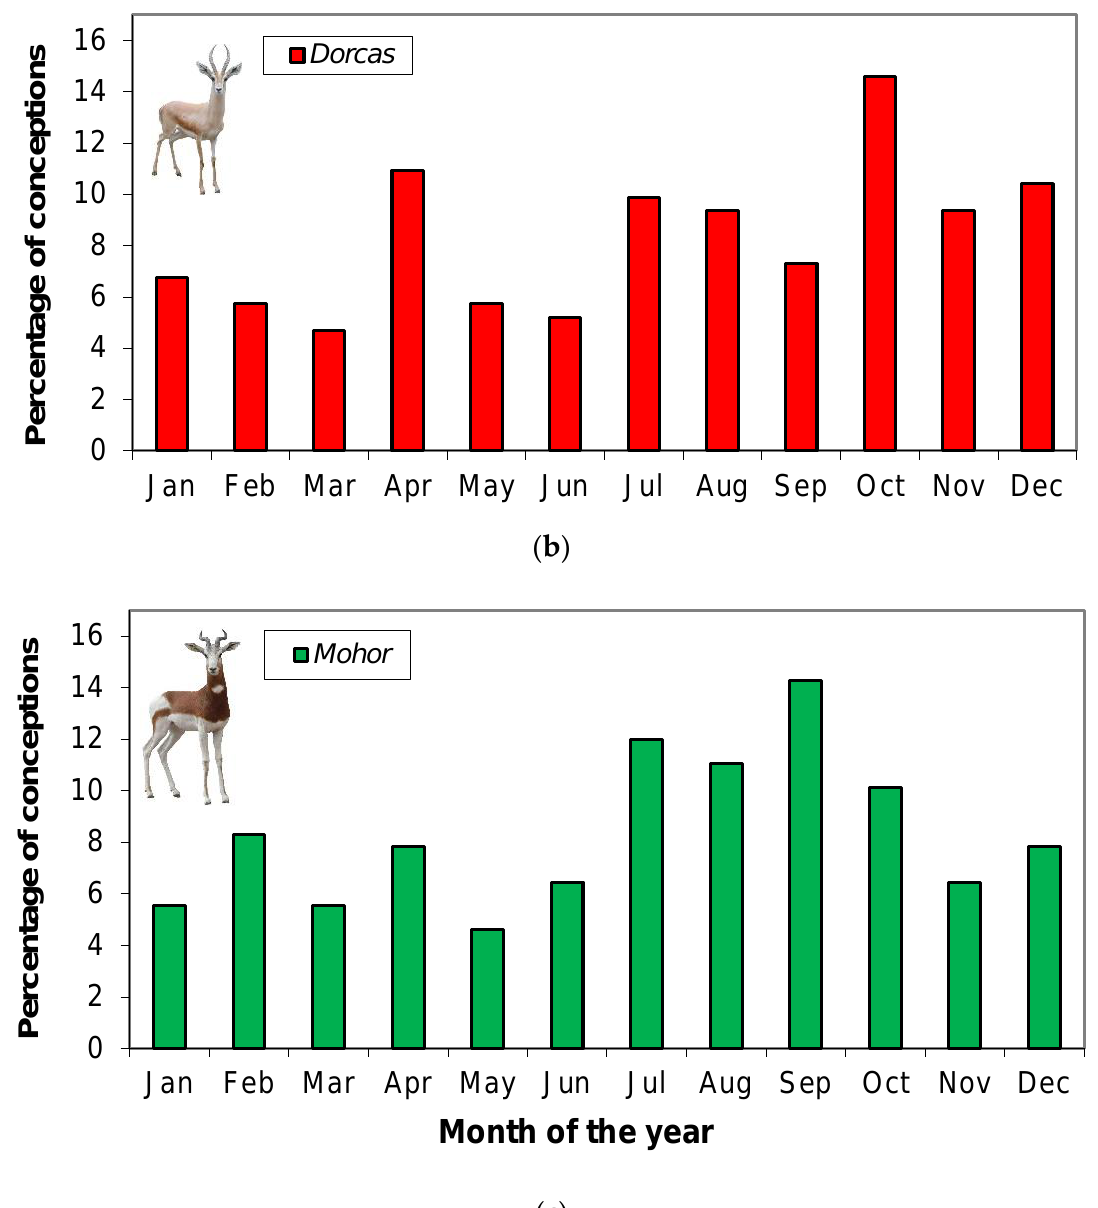
Figure 2. Distribution of conception dates for ( a ) Cuvier’s gazelle, ( b ) dorcas gazelle and ( c ) Mohor gazelle, data of dates of birth at Estación Experimental de Zonas Á ridas from January 1995 to December 2005 were taken from studbooks. Cuvier’s gazelle n = 146, dorcas gazelle n = 192 and Mohor gazelle n = 217.